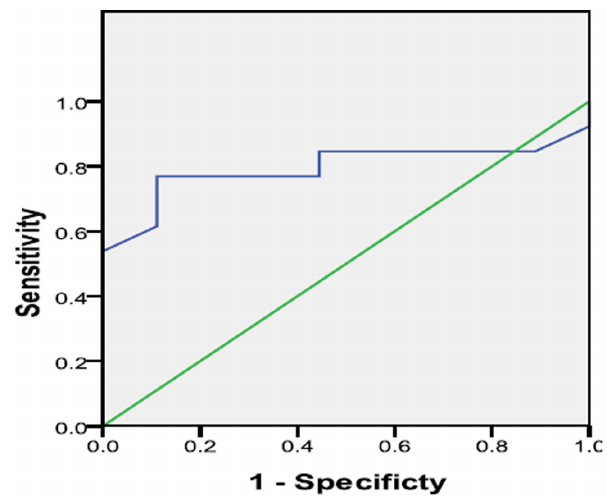
Figure 3. ROC curve of the percentage of CD62E + SEMPs. The area under the curve of the percentage of CD62E + SEMPs was